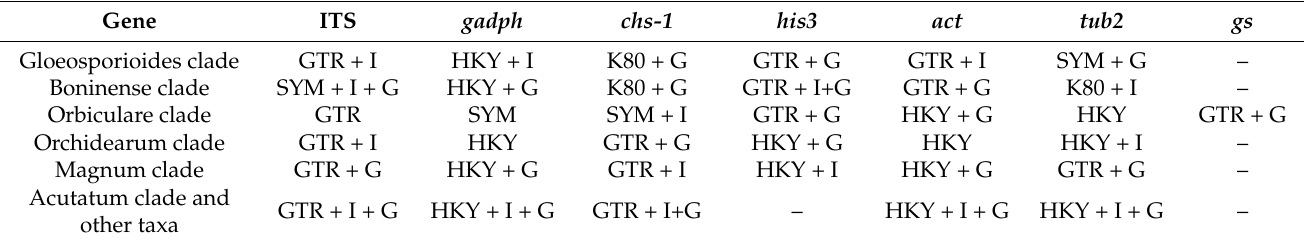
Table 2. Nucleotide substitution models used in the phylogenetic